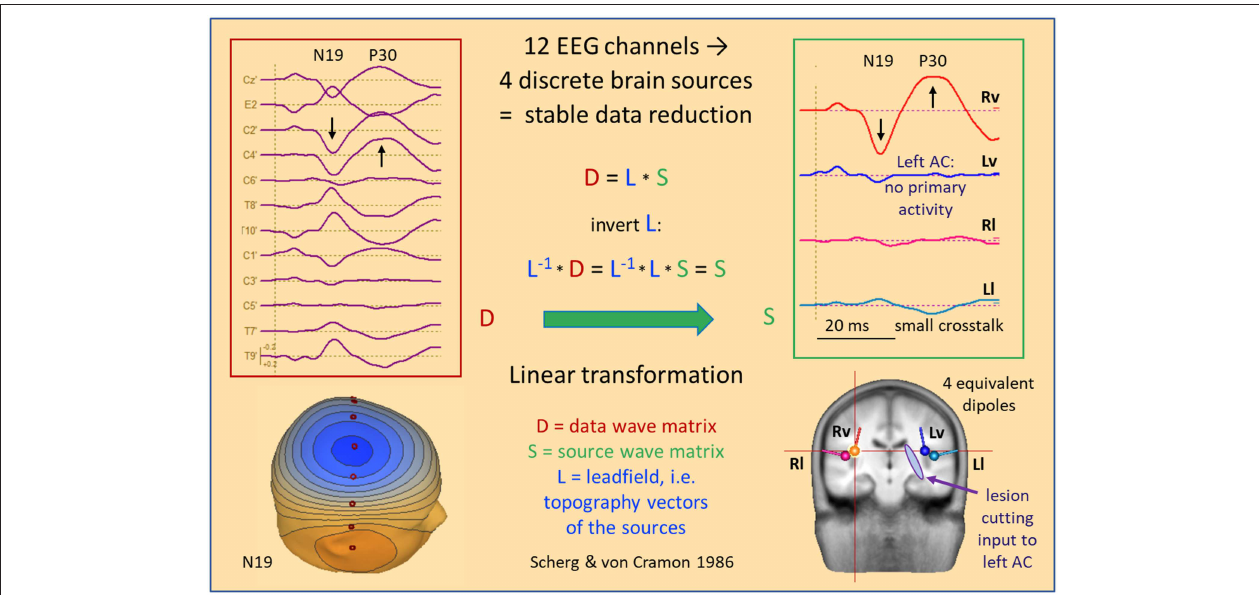
FIGURE 7 | MAEP of a patient with a white matter lesion cutting the input to left AC (2). The distance between scalp traces corresponds to 0.6 µ V and transforms into 10 nAm between source waveforms. Filter settings: 10Hz forward to 200Hz. The 12 EEG channels in the coronal plane show a right sided dipolar map with the negativity of N19 near the vertex. MAEP scalp potentials are displayed positive up and dipoles with the orientation outward of the cortex—opposite to IEDs—to display P30 upward in the scalp and source waveforms. The linear transformation into standard AEP cortical source space reduces the data to the vertical (Rv, Lv) and lateral (Rl, Ll) activities of the Heschl’s gyrus on both sides. Thus, it is immediately apparent that the primary activity of left AC is completely abolished by the lesion whereas the healthy right AC exhibits the typical N19-P30 pattern of the